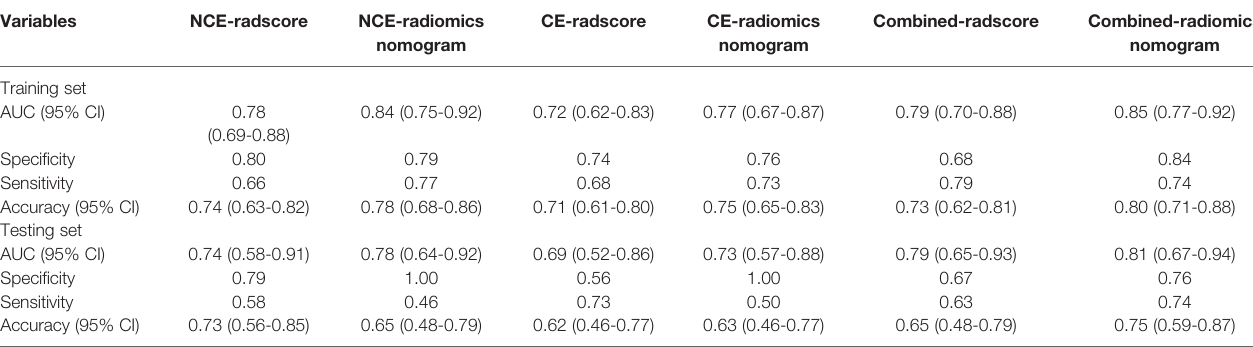
TABLE 3 | ROC analysis for NCE-radiomics, CE-radiomics and combined-radiomics models from largest lesion approach.